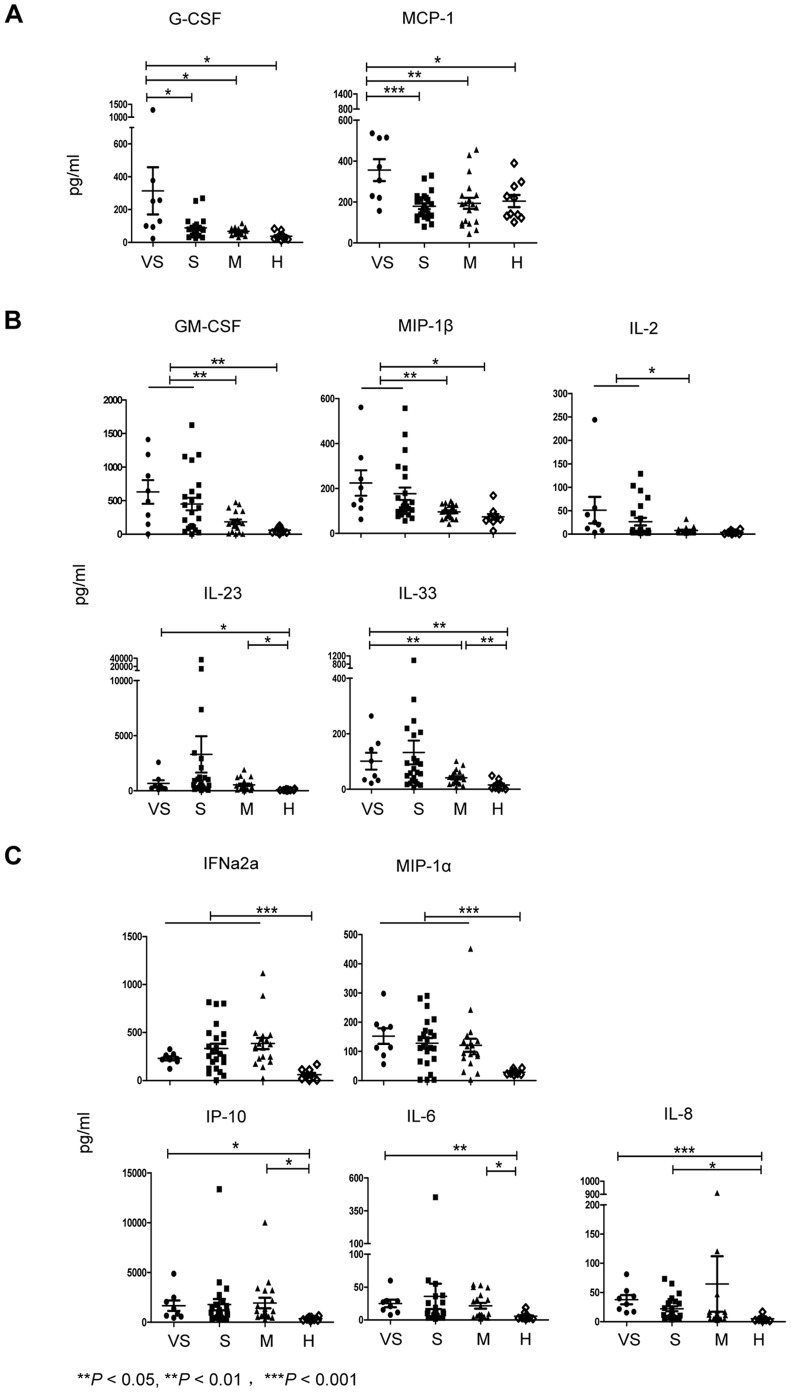
Peripheral cytokine/chemokine expression was compared between EV71-positive HFMD patient groups stratified by disease severity.(A, B, C) The profiles of 12 cytokines/chemokines were significantly elevated in plasma samples from recruited EV71-positive HFMD patients: VS = severe patients with pulmonary edema, n = 8; S = severe patients with uncomplicated neurological manifestations, n = 23; M = mild patients without neurological syndromes, n = 19; and H = healthy controls, n = 10. (A) G-CSF and MCP-1 were significantly increased in plasma from very severe patients with acute respiratory failure. (B) Cytokines/chemokines were markedly elevated in plasma of both very severe and severe patients. (C) Cytokines/chemokines were significantly enhanced in all HFMD patients compared to healthy controls. The unpaired Student’s t-test and non-parametric ANOVA test were used to compare variables between any two groups and P value from unpaired Student’s t-test analysis was presented in figures. *P<0.05, **P<0.01,***P<0.001. Each assay was performed duplicate and data are representative of at least 2 independent experiments.